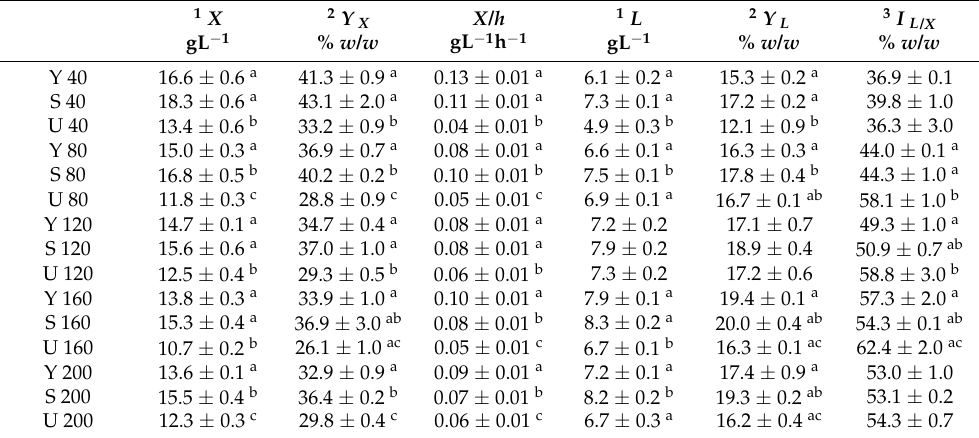
Table 6. Performance of L. tetrasporus DSM 70314, grown on wheat straw hydrolysate (30 gL − 1 glucose, 16 gL − 1 xylose) with three different nitrogen sources: Yeast extract (Y), Soy flour (S), and Urea (U), and 5 different C/N ratios, 40, 80, 120, 160, and